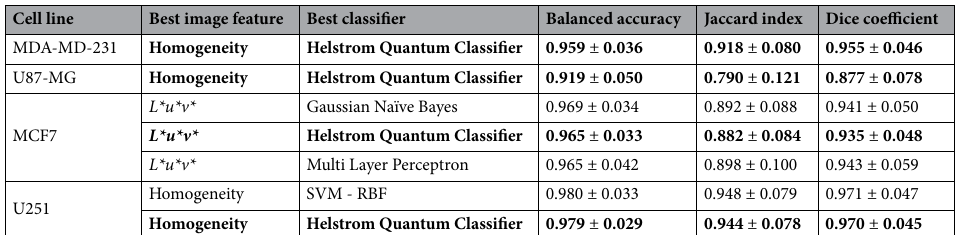
Table 1. The mean and standard deviation balance accuracy score (with respect to 30 datasets) for the best performing image feature and classifiers (up to and including HQC and classifiers where the score was tied with HQC), with corresponding mean and standard deviation Jaccard index and Dice coefficient, for cell lines MDA-MD-231, U87-MG, MCF7 and U251. The rows in boldface denote the results achieved by the HQC.